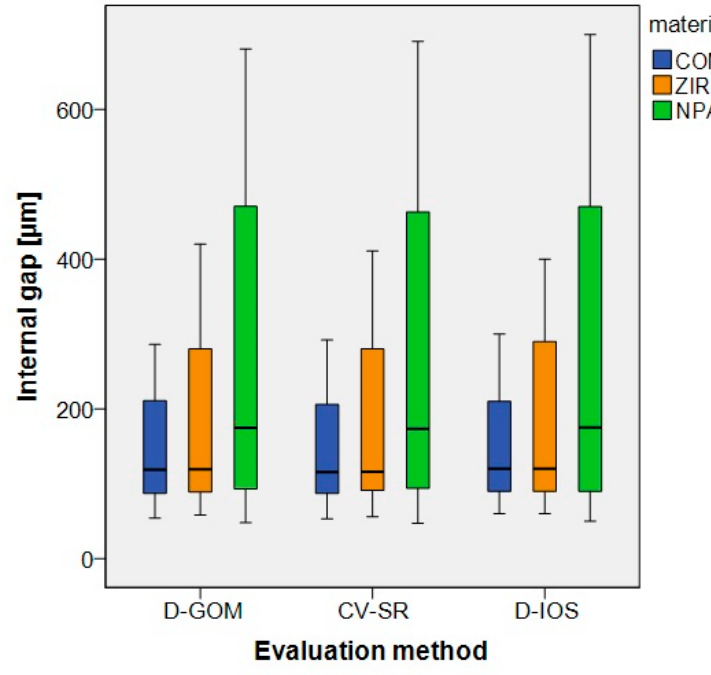
Figure 4. Boxplots of the three evaluation methods (D-GOM, CV-SR and D-IOS).